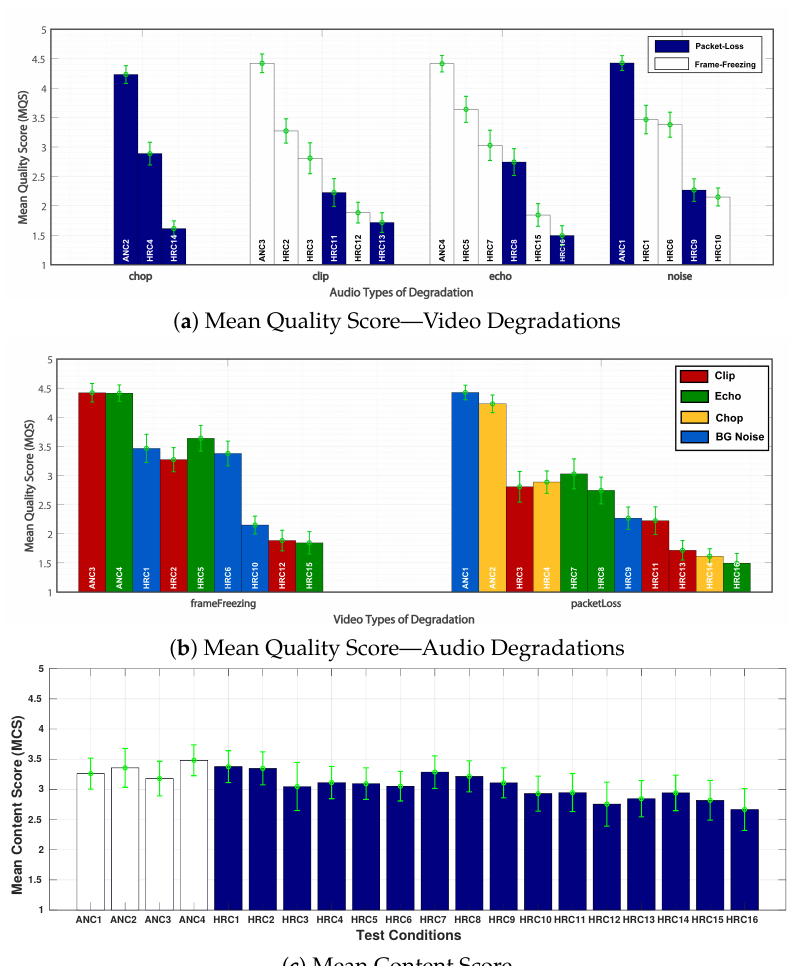
Figure 10. Mean Quality Score (MQS HRC ) and Mean Content Score (MCS HRC ) for the different Hypothetical Reference Circuit (HRC) in Experiment